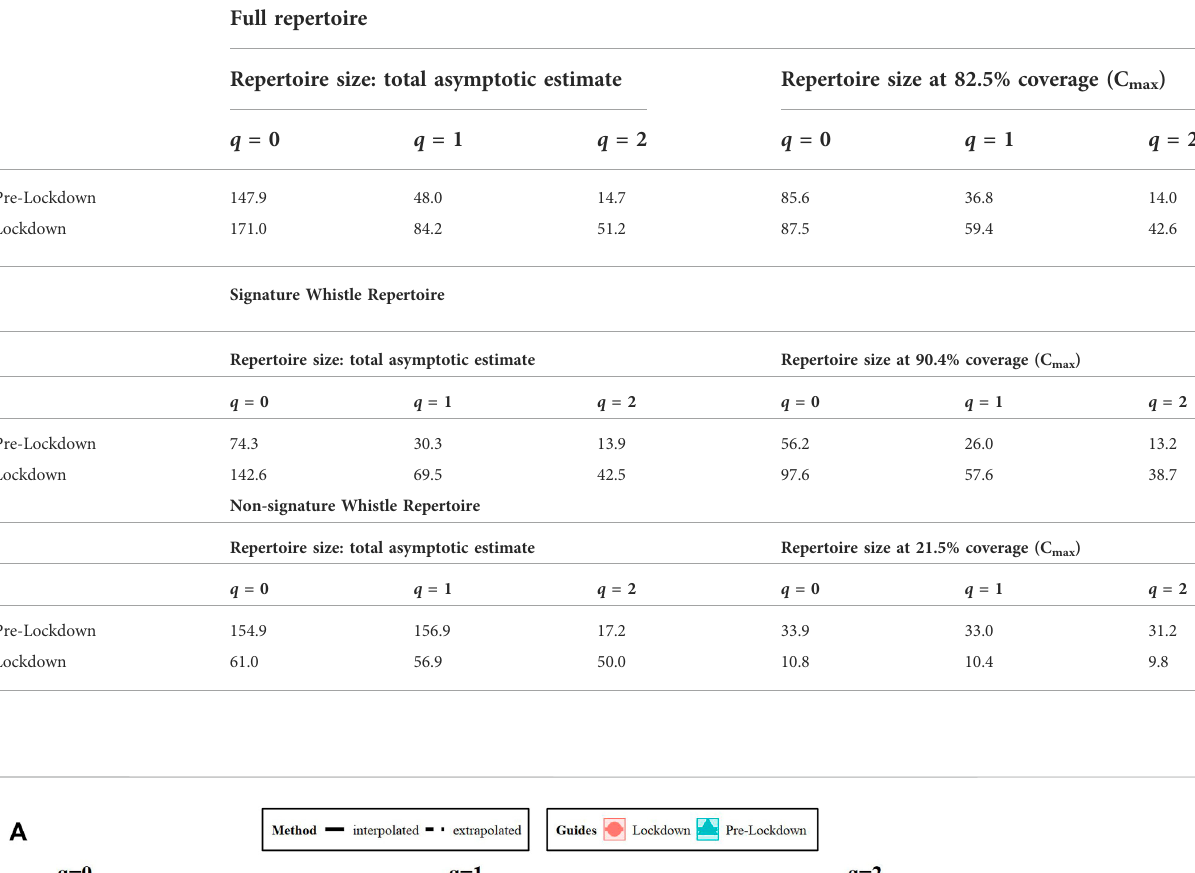
TABLE4Asymptoticdiversityestimatesandestimatesat82.5%,90.4%,and21.5%samplecoverageforthefullrepertoire,onlysignaturewhistles,and onlynon-signaturewhistles,respectively.Valuesrepresenteffectivenumberofwhistles.(q=0estimatesspeciesrichness,q=1istheexponential of Shannon entropy, q = 2 is the inverse of the Simpson concentration index).